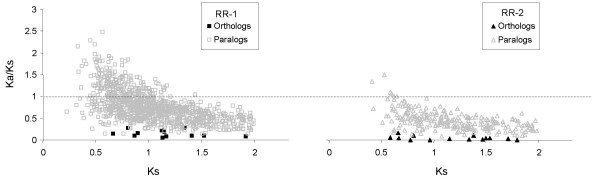
Ka/Ks of RR-1 and RR-2 single-copy genes. Ka/Ks is plotted as a function of Ks for all An. gambiae paralog pairs and all An. gambiae – Ae. aegypti ortholog pairs for which the estimated Ks < 2. Genes in sequence clusters are excluded because they are likely to be products of recent duplication or gene conversion, which can bias Ka/Ks.